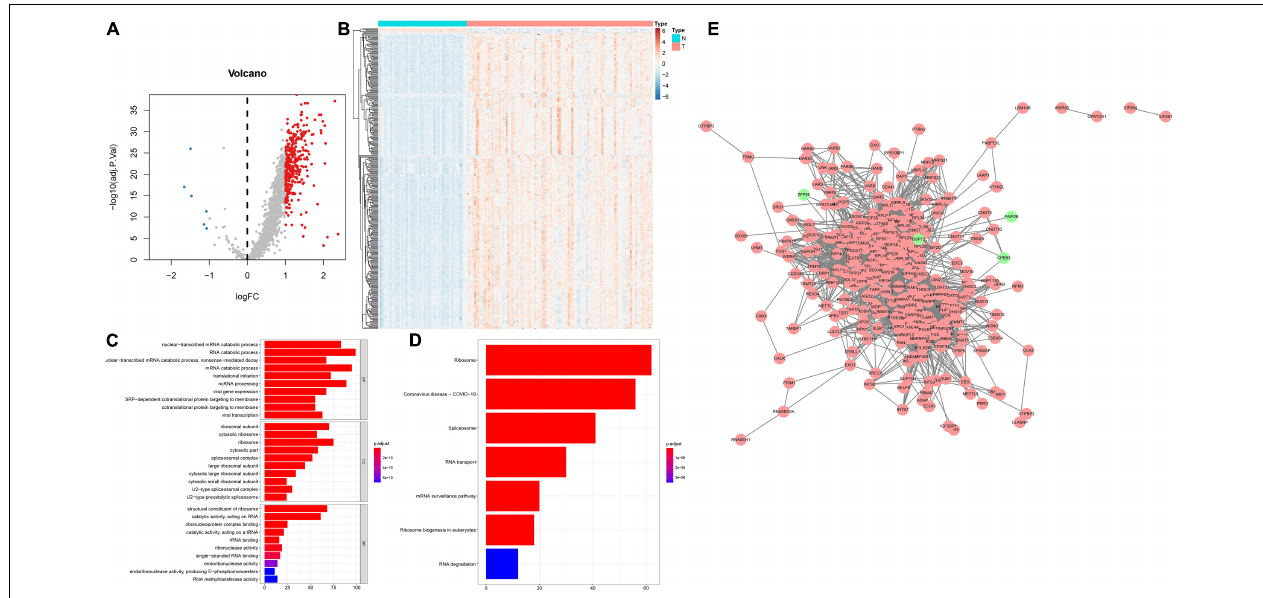
FIGURE 1 | Expression patterns and functions of RBPs in HBV-related HCC tissues. (A) Volcano plots of up- and down-regulated RBPs in HBV-related HCC than control specimens. Red dots represented up-regulated RBPs; blue dots represented down-regulated RBPs; gray dots represented no differentially expressed RBPs. (B) Heatmap visualizing expression values of up- (red) and down-regulated (blue) RBPs in HBV-related HCC and control specimens. (C) The first ten biological processes (BPs), cellular components (CCs) and molecular functions (MFs) involved in differentially expressed RBPs. (D) KEGG pathways enriched by above RBPs. The longer the band, the greater the number of enriched genes. The more the color tended to red, the smaller adjusted p-value. (E) A PPI network based on the differentially expressed RBPs. Red indicated up-regulated RBPs and green indicated down-regulated RBPs.